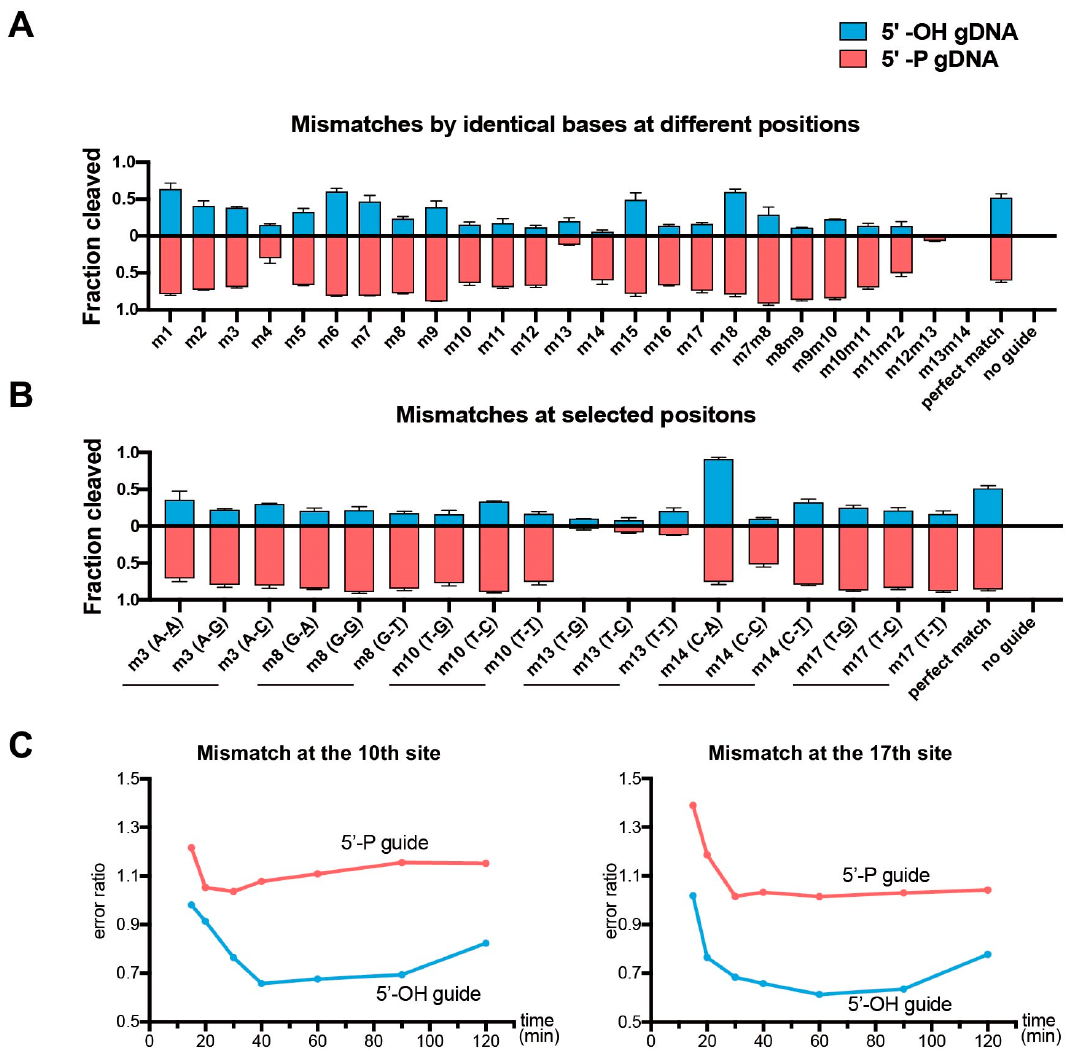
Figure 4. Effects of the guide-target mismatches on the cleavage activity of CdAgo. Quantitative analysis of the cleavage fraction with the 5 ′ -OH or 5 ′ -P guides containing mismatches. ( A ) The catalytical effects of the identical base-paring mismatches at all positions. ( B ) The catalytic effects of selected mismatches at various positions. ( C ) Error ratio of CdAgo cleavage. The error ratio is defined as the ratio of cleavage product yield for the mismatched versus matching guide at the same reaction time point (Yield(mismatched)/Yield(matched)). The corresponding urea-PAGE analyses are shown in Figure S4. Means and standard deviations from three independent experiments are shown in ( A , B ).